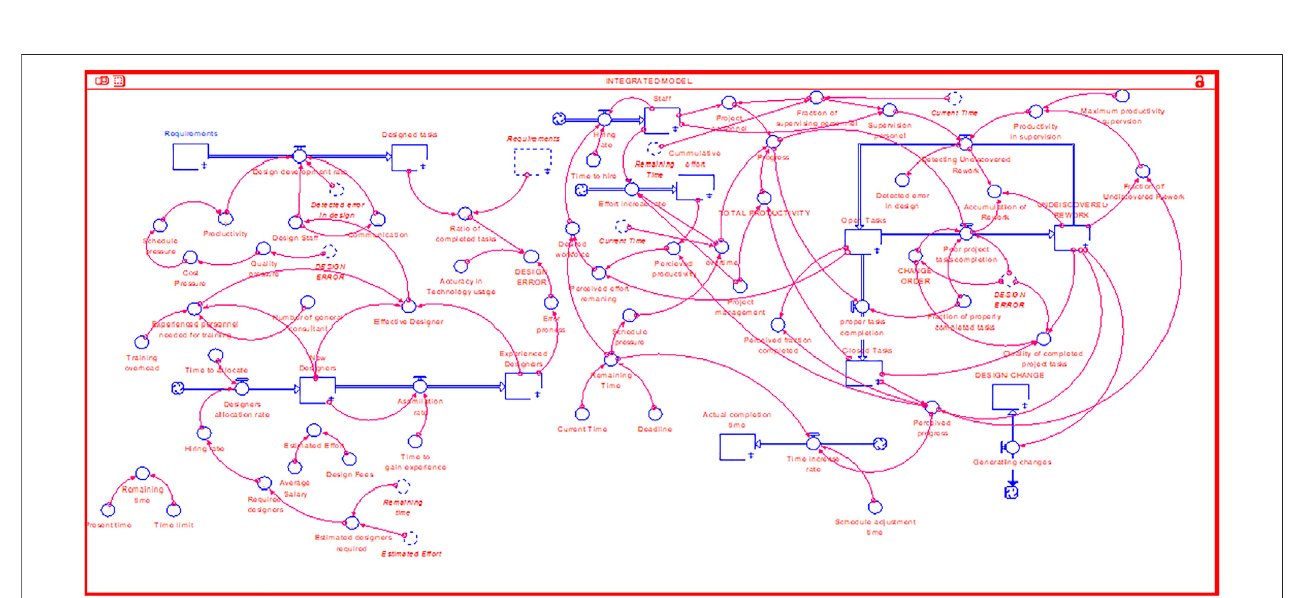
FIGURE 3 | Causal relationships among key construction delay factors.